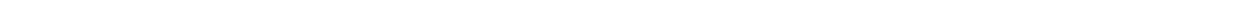
Fig. 5 vRNA regions required for PR8 replication are required for replication of contemporary avian and human IAV. a Phylogenetic analysis of segment 5. WT-PR8, WT-H7N3, or WT-pH1N1 IAV are indicated by corresponding, labeled arrows. Phylogenies were created from randomly sampled